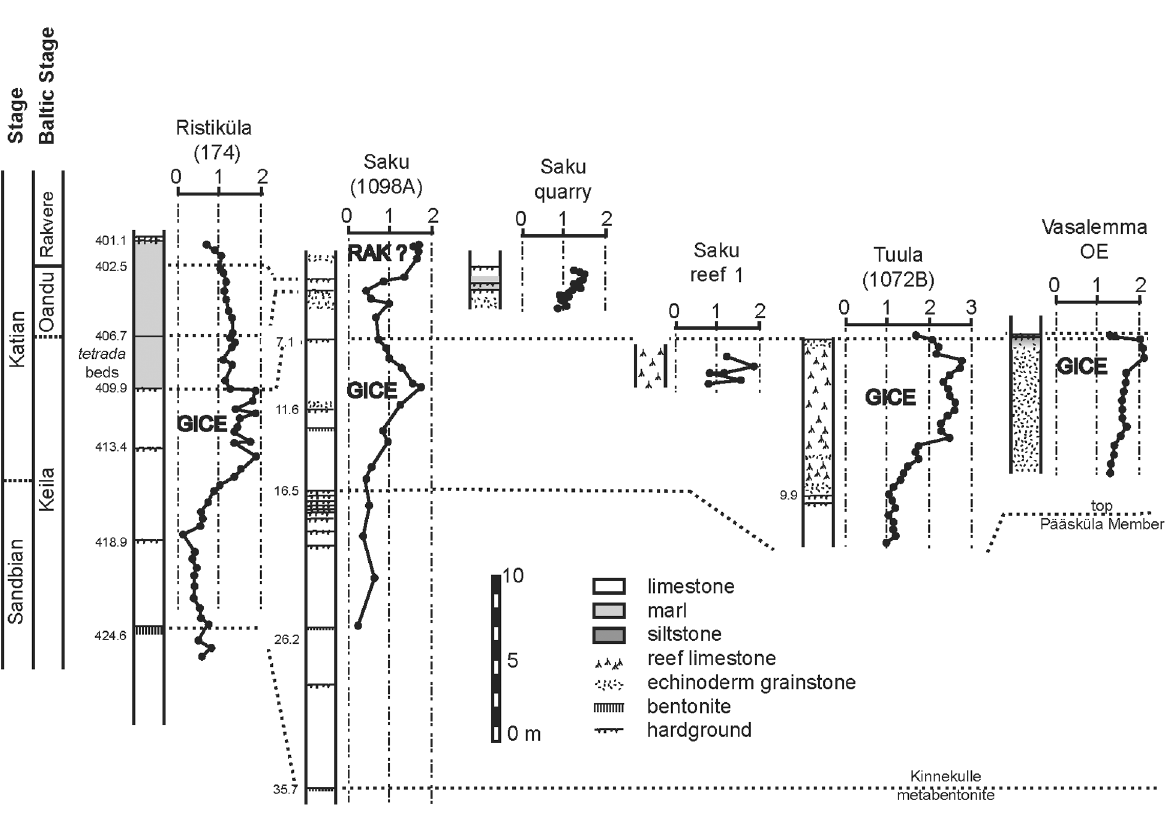
Fig. 3. δ 13 C chemostratigraphy of selected early Katian outcrops in Estonia. δ 13 C values in (cid:137) V-PDB. Keila/Oandu stage boundary after Pılma et al. (1988) and Ainsaar et al. (1999). Data from Saku-1098A after Kaljo et al. (2004), from Ristik(cid:252)la-174 (see Fig. 1) after Ainsaar et al. (2004), from Vasalemma after Kr(cid:246)ger et al. (2014). GICE (cid:150) Guttenberg Isotopic Carbon Excursion; RAK? (cid:150) questionable Rakvere/Kope Isotopic Carbon Excursion. Note the pre-Oandu occurrence of the Vasalemma facies in the Saku and Tuula reefs and in the Vasalemma